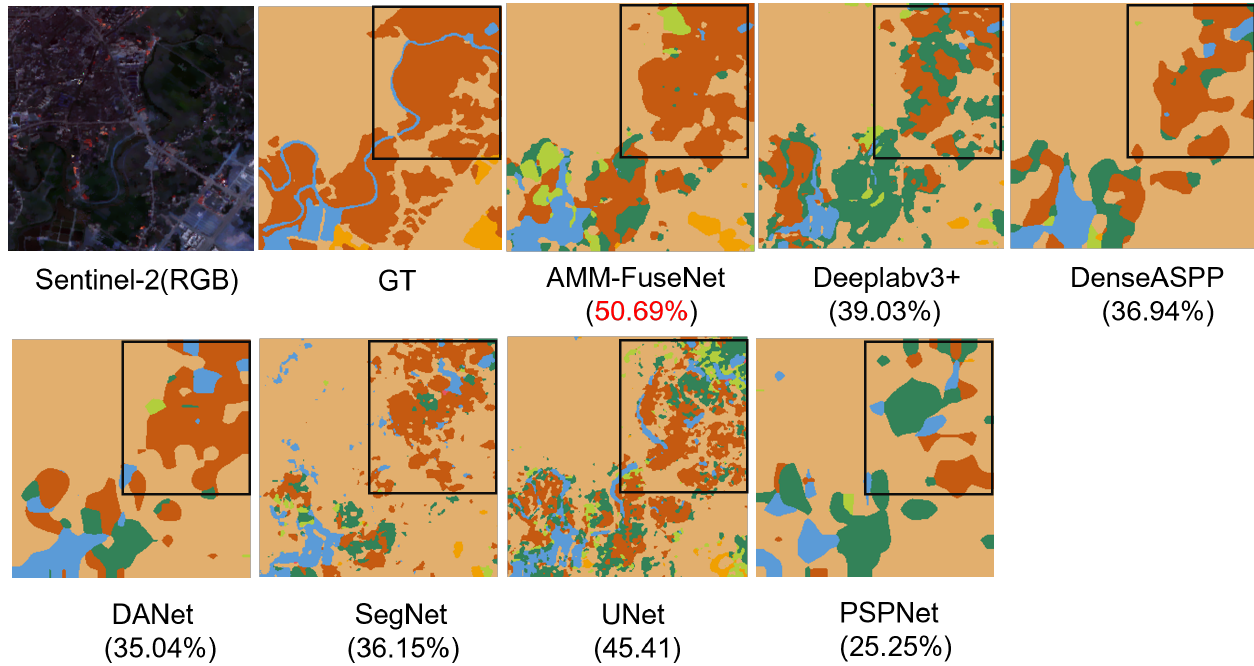
Figure 7. Results on the Hunan dataset (Sentinel-2 and Sentinel-1). Values between parentheses refer to mIoU in percentages for the example image for each model, where the best model is shown in red.